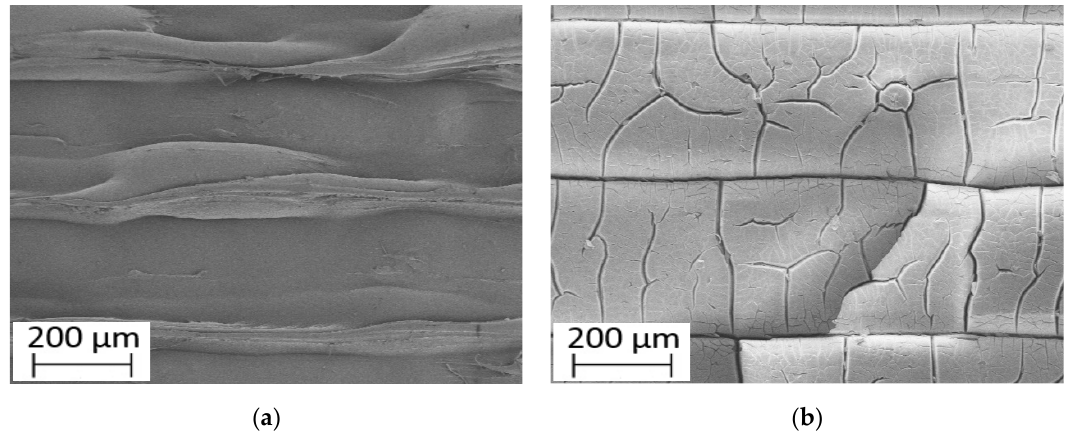
Figure 4. SEM images of the surface of uncoated ABS specimen ( a ) before and ( b ) after 1200 h of exposure to UV radiation and moisture.